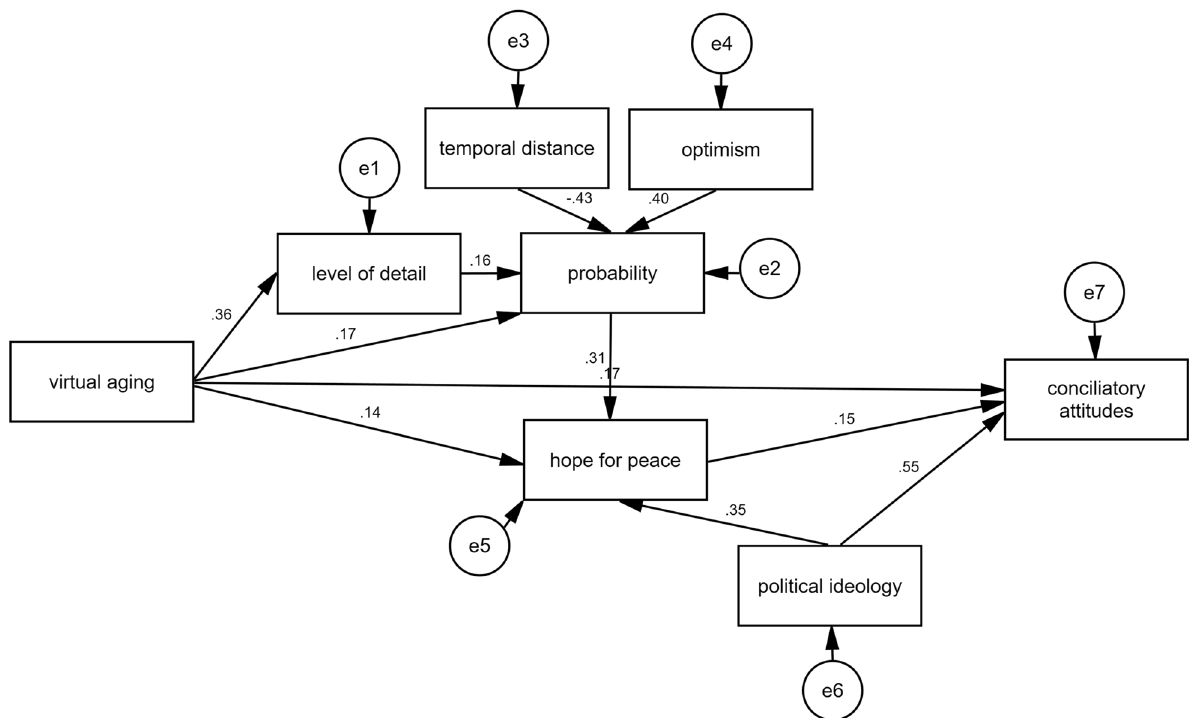
Figure 4. Path analysis model of the virtual aging effect on hope for peace and conciliatory attitudes. The model is based on data of anticipated positive collective future events . Boxes represent the variables where virtual aging is coded as 1 = virtual aging, 0 = control, level of detail is the word count of event descriptions, probability is the perceived probability of generated events with 1 (lowest) to 4 (highest), temporal distance is the time